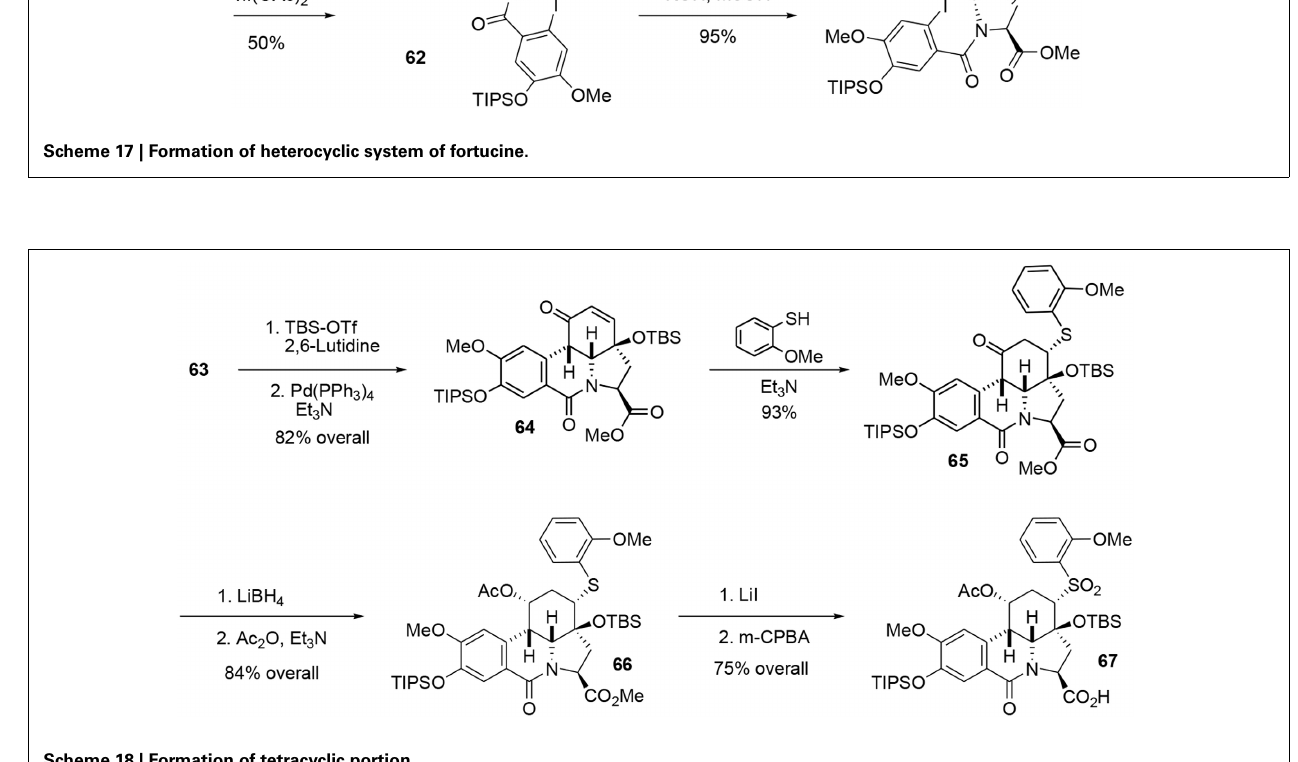
Scheme 18 | Formation of tetracyclic portion.